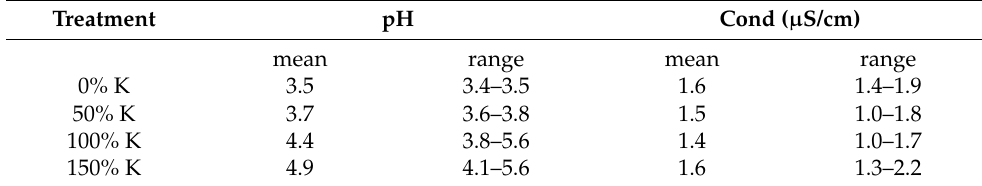
Table 1. pH and conductivity (Cond) of culture medium in potassium treatments.